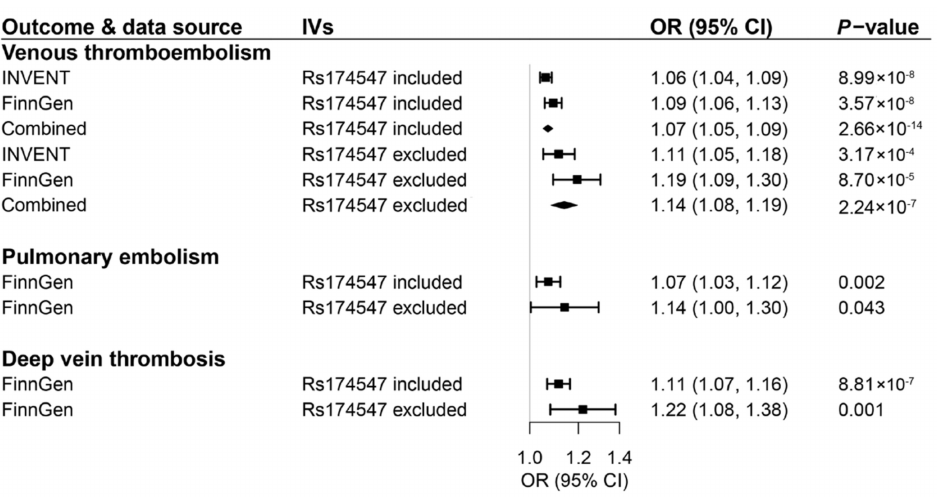
Figure 3. Associations of genetically predicted circulating levels of fatty acids with risk of pulmonary embolism and deep vein thrombosis in the FinnGen study. CI indicates confidence interval; OR, odds ratio. The associations were scaled to one standard deviation increment in genetically predicted circulating levels of fatty acids.